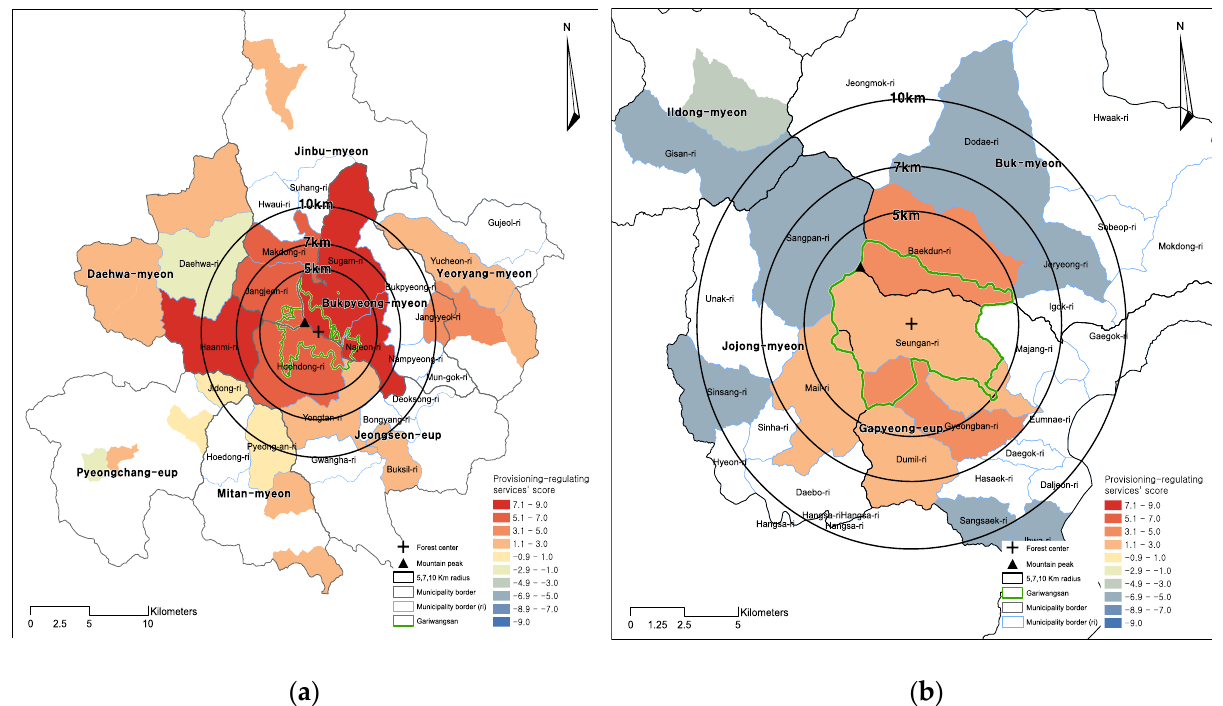
Figure 2. Score maps of competing ecosystem services (provisioning versus regulating ES categories) in ( a ) Gariwangsan and ( b ) Yeoninsan.